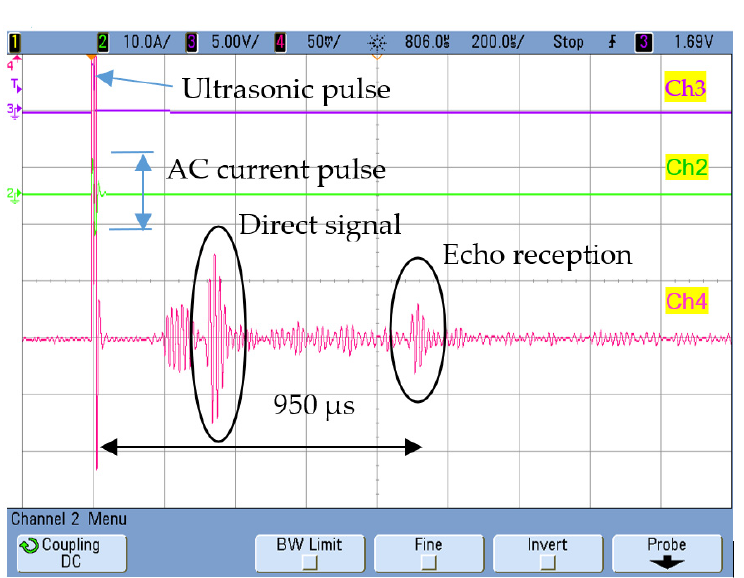
Figure 4. Ch1 [2 V/div]: Signal from the power stage. Ch2 [5 A/div]: resonant current. Ch4: [50 mV/div]: Bounce detection on the blockage 2 m away from the emitter.